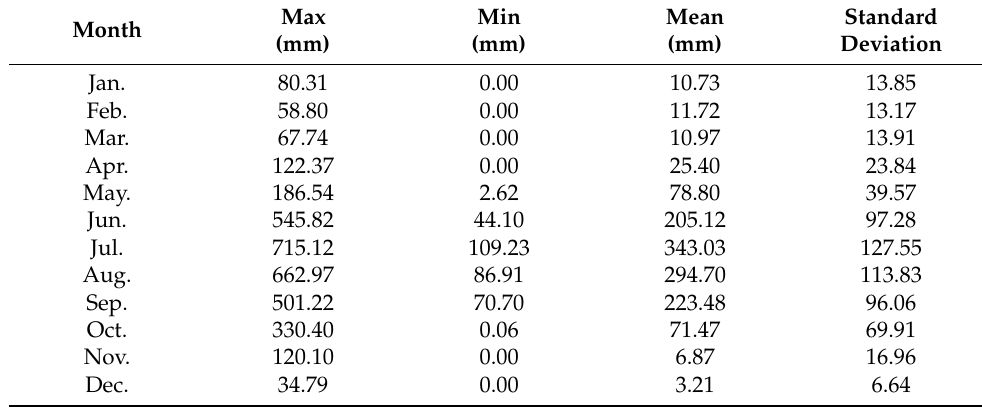
Figure 2. Characteristics of long term (1901–2016) precipitation over KRB; ( a ) Regionally averaged mean monthly precipitation and ( b ) Spatial distribution of mean annual precipitation. Table 2. Basic statistical characteristics of the 116 years precipitation of